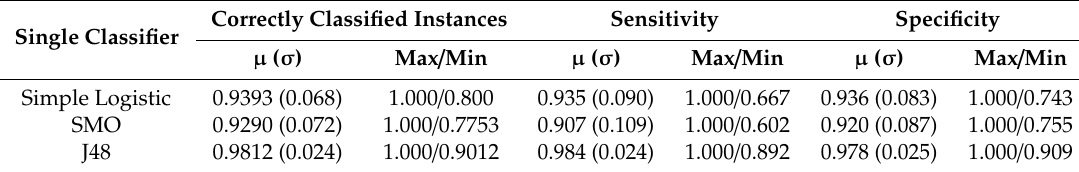
Table 4. Comparison of the prediction results of di ff erent model for